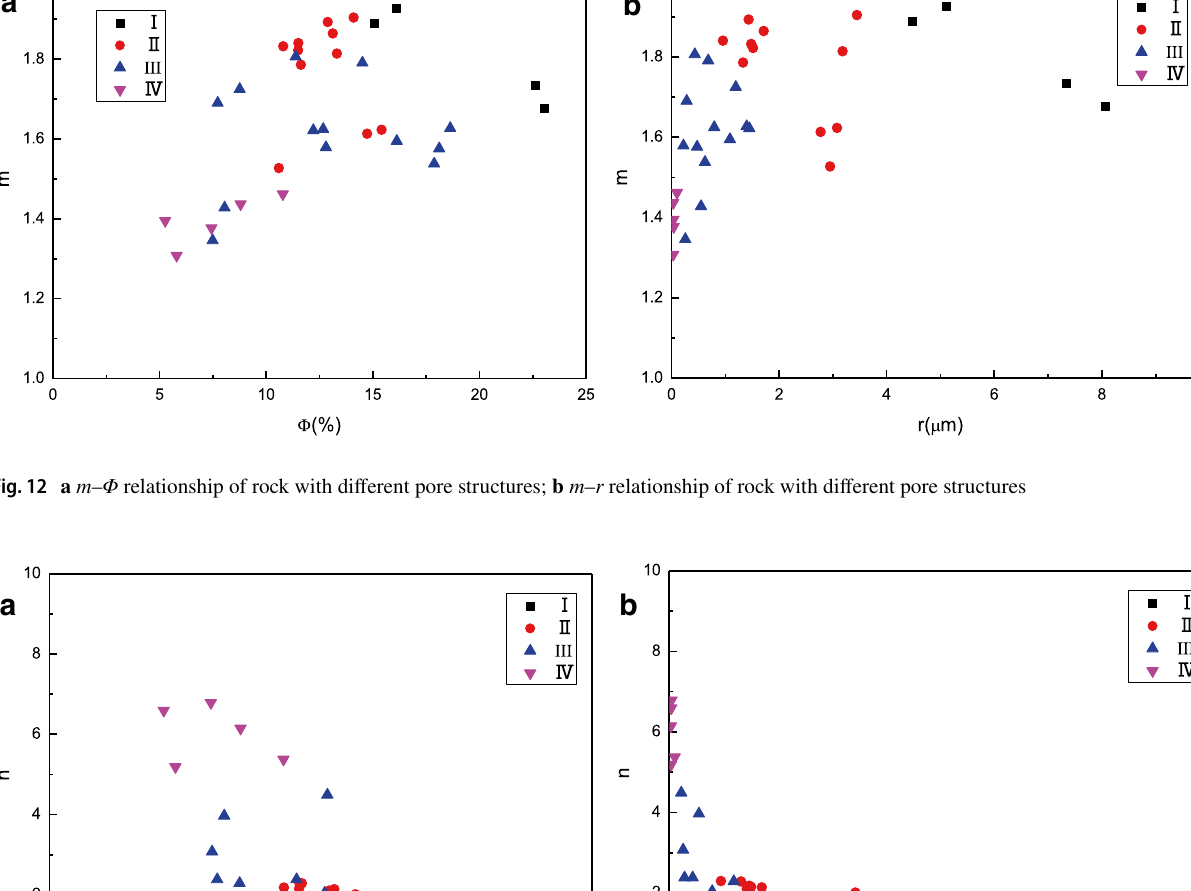
Fig. 13 a n – Φ relationship of rock with different pore structures; b n – r relationship of rock with different pore